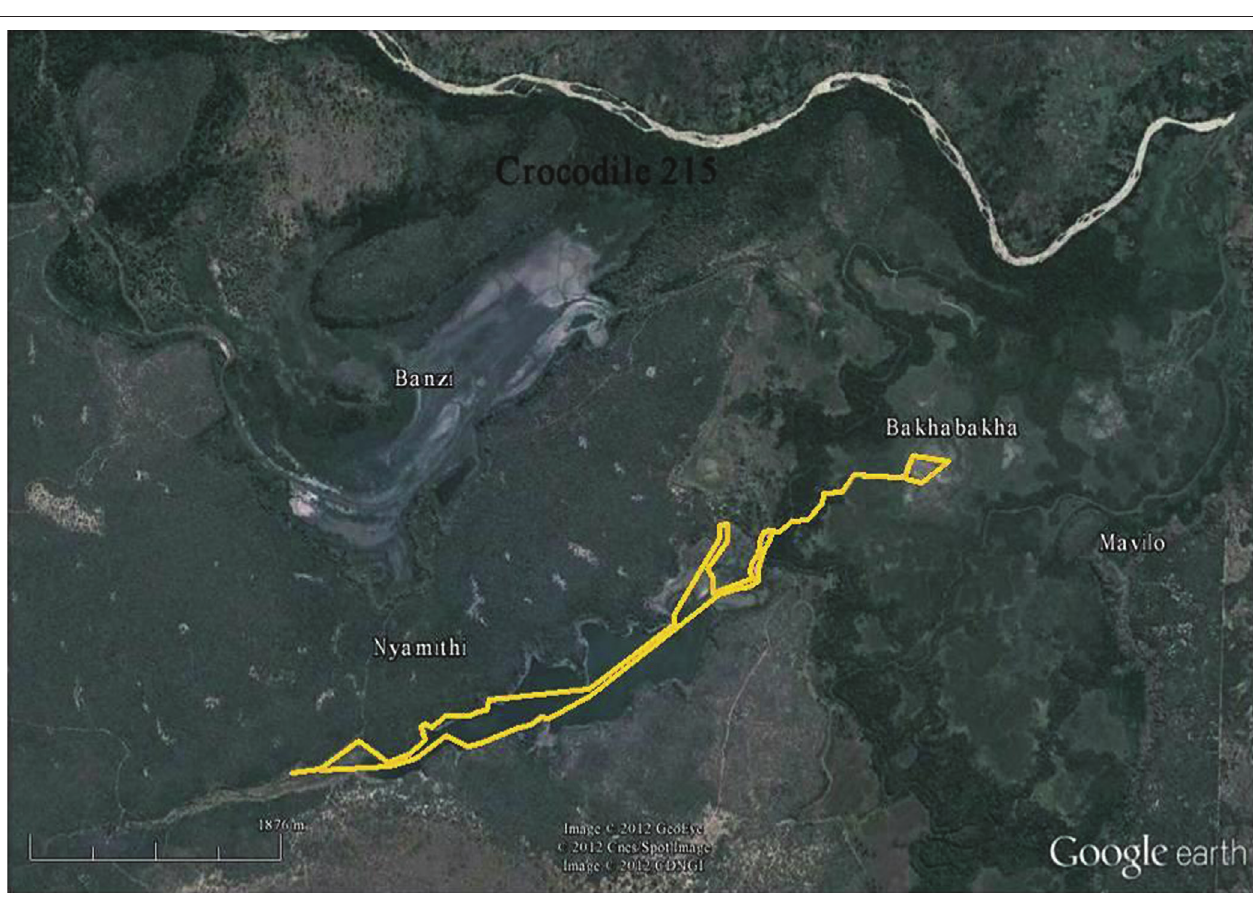
FIGURE A1: Home range of Nile crocodile 215 (yellow line) in Ndumo Game